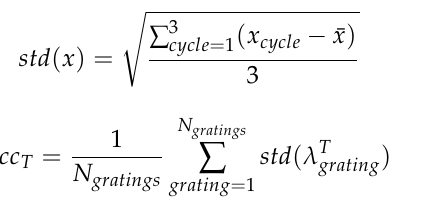
Table 1. Calibration accuracy.